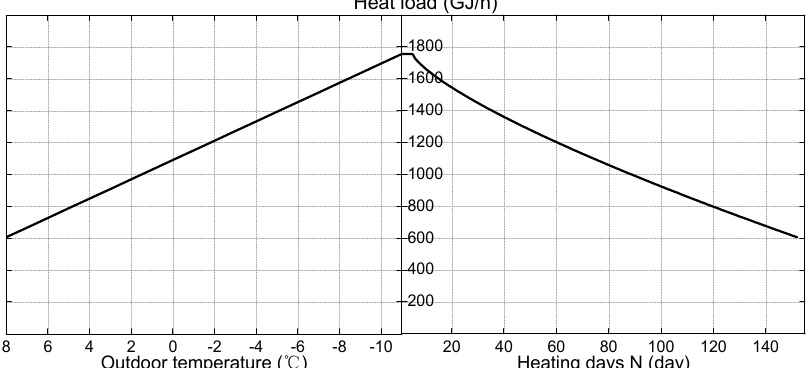
Figure 4. Heat load delay curve of the demonstration power plant during the 2016–2017 heating season.